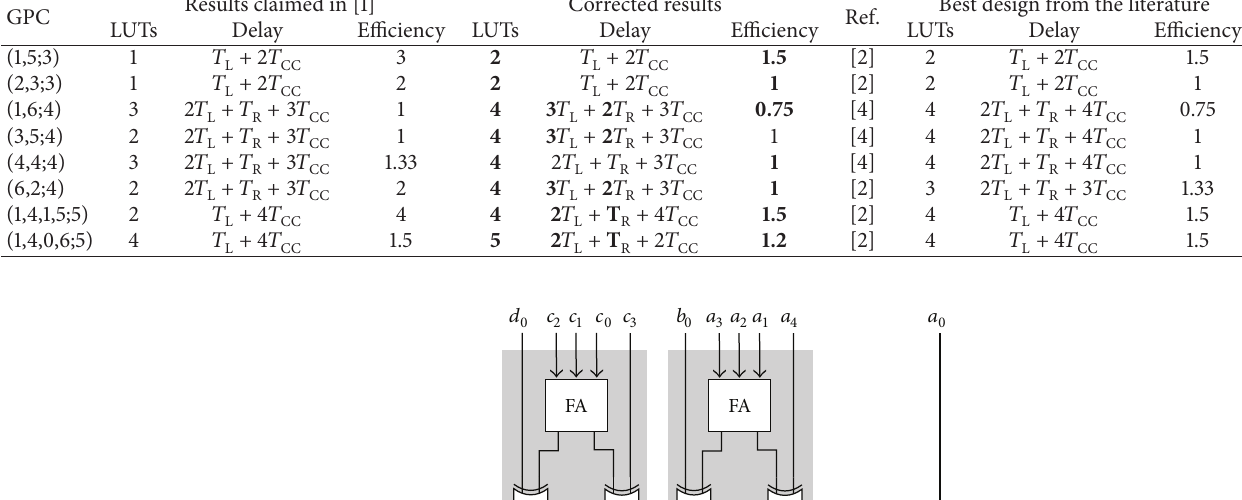
Table 1: Corrected mapping results of GPCs in [1] when using Xilinx Virtex 5 FPGAs (corrected values are marked in bold).